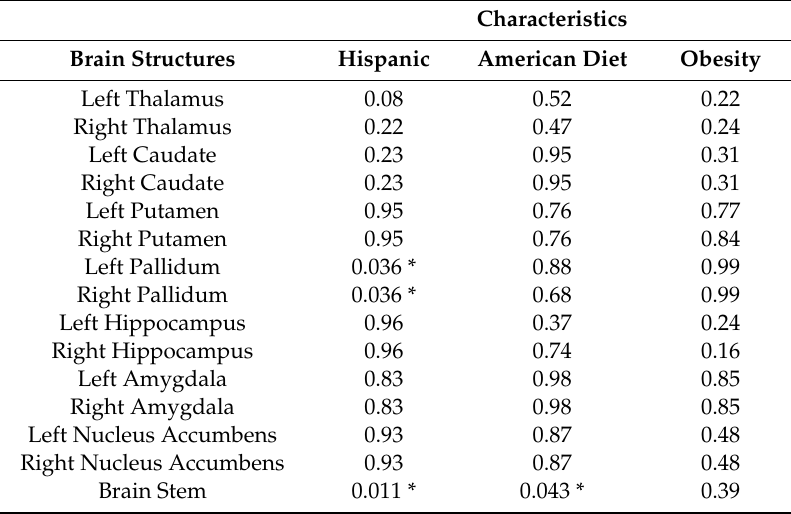
Table 4. Multiple one-way ANOVA q -values of characteristics associated with brain structural volumes adjusted for FDR.